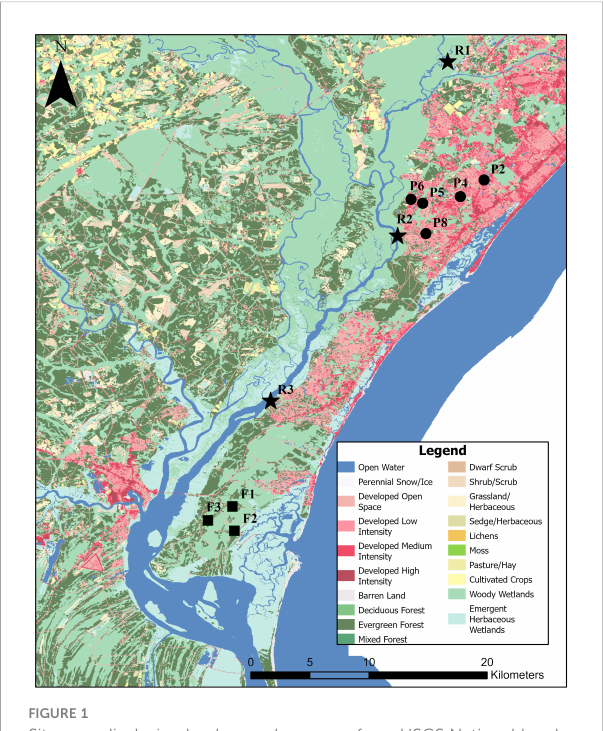
FIGURE 1 Site map displaying land cover base map from USGS National Land Cover Database (https://www.usgs.gov/centers/eros/science/ national-land-cover-database). The different symbols refer to the different site types and locations with circles, stars, and squares corresponding to stormwater detention ponds (P), Waccamaw River (R), and forested wetland (F) sites. See Table 1 for site